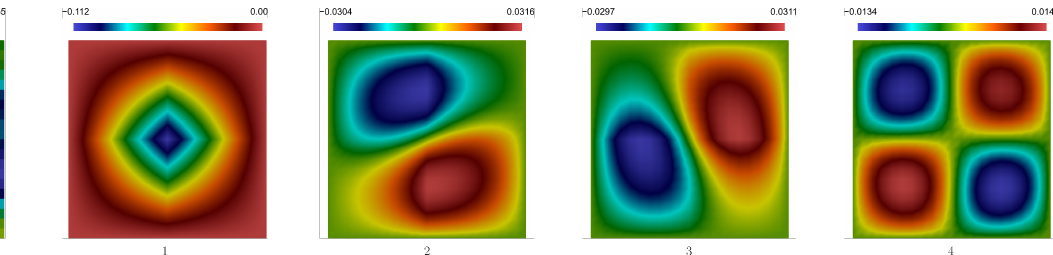
Figure 3. An example of the solid heat conductivity coefficient k s and the first 4 offline multiscale basis functions for temperature (from left to right) in the local domain ω i